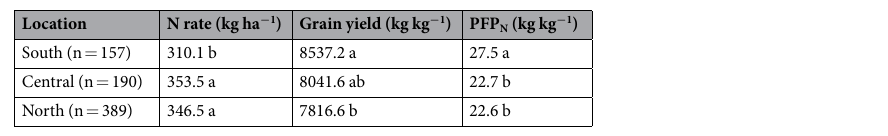
Table 2. N rate, grain yield and N partial factor productivity (PFP N ) in famer’s field in Jiangsu by the farmer